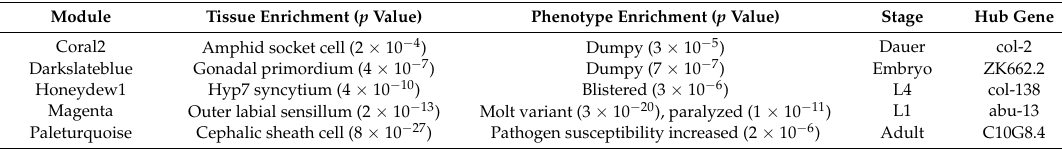
Table 3. Five modules that may correlate with molting in C.